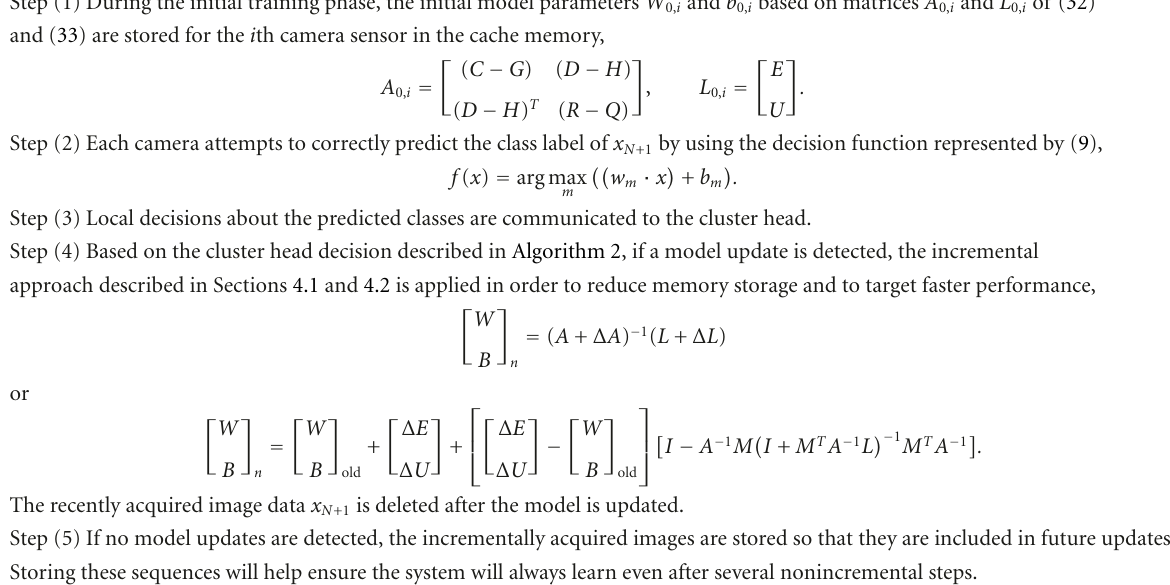
Algorithm 1: Sensor nodes operations.